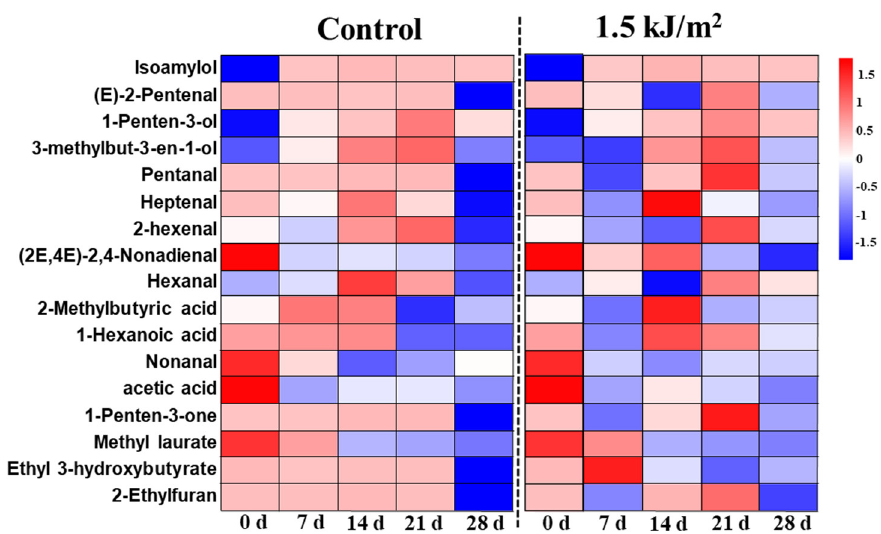
Figure 5. Changes in the level of flavor compounds in pulp tissues of pepino fruit treated with UV-C tand control fruit during storage. The median value of the graph is drawn after logarithmic transformation (log10). The redder the color, the higher the content. GC-MS analysis was conducted on pulp tissues.